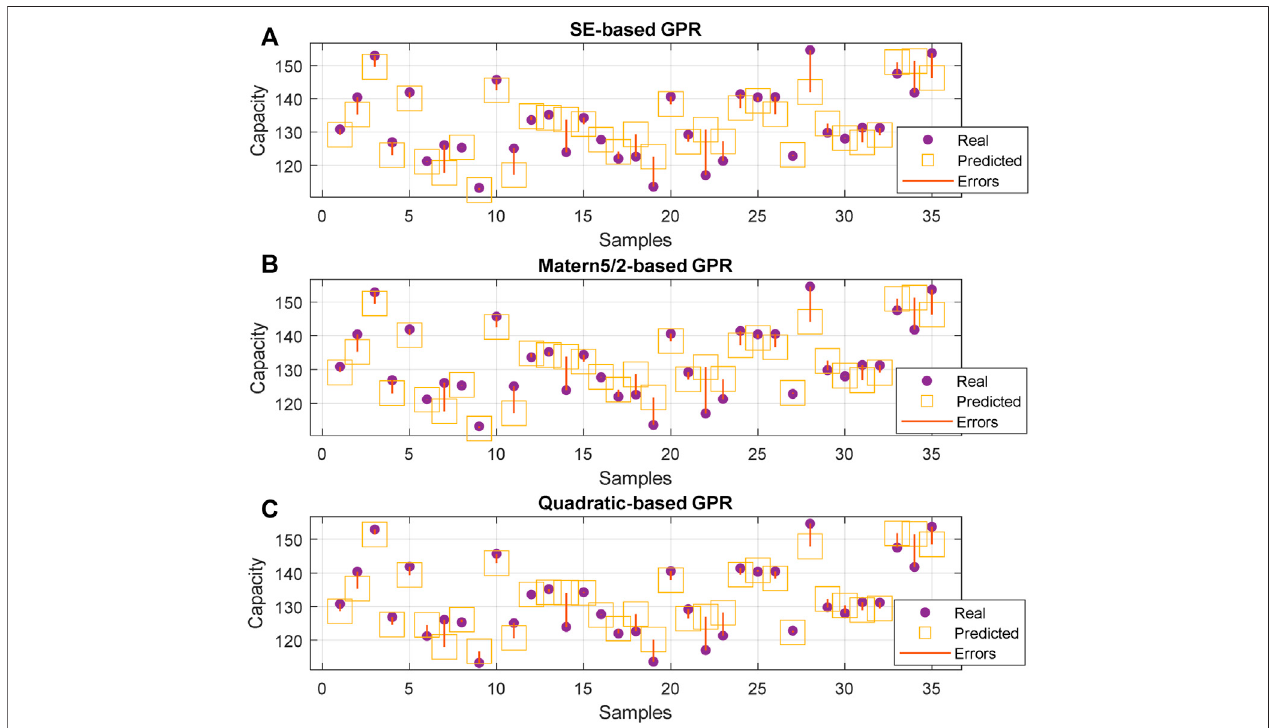
TABLE 1 | Performance indicators for battery capacity predictions by using the GPR-based data-driven model with different ARD kernels. Kernel